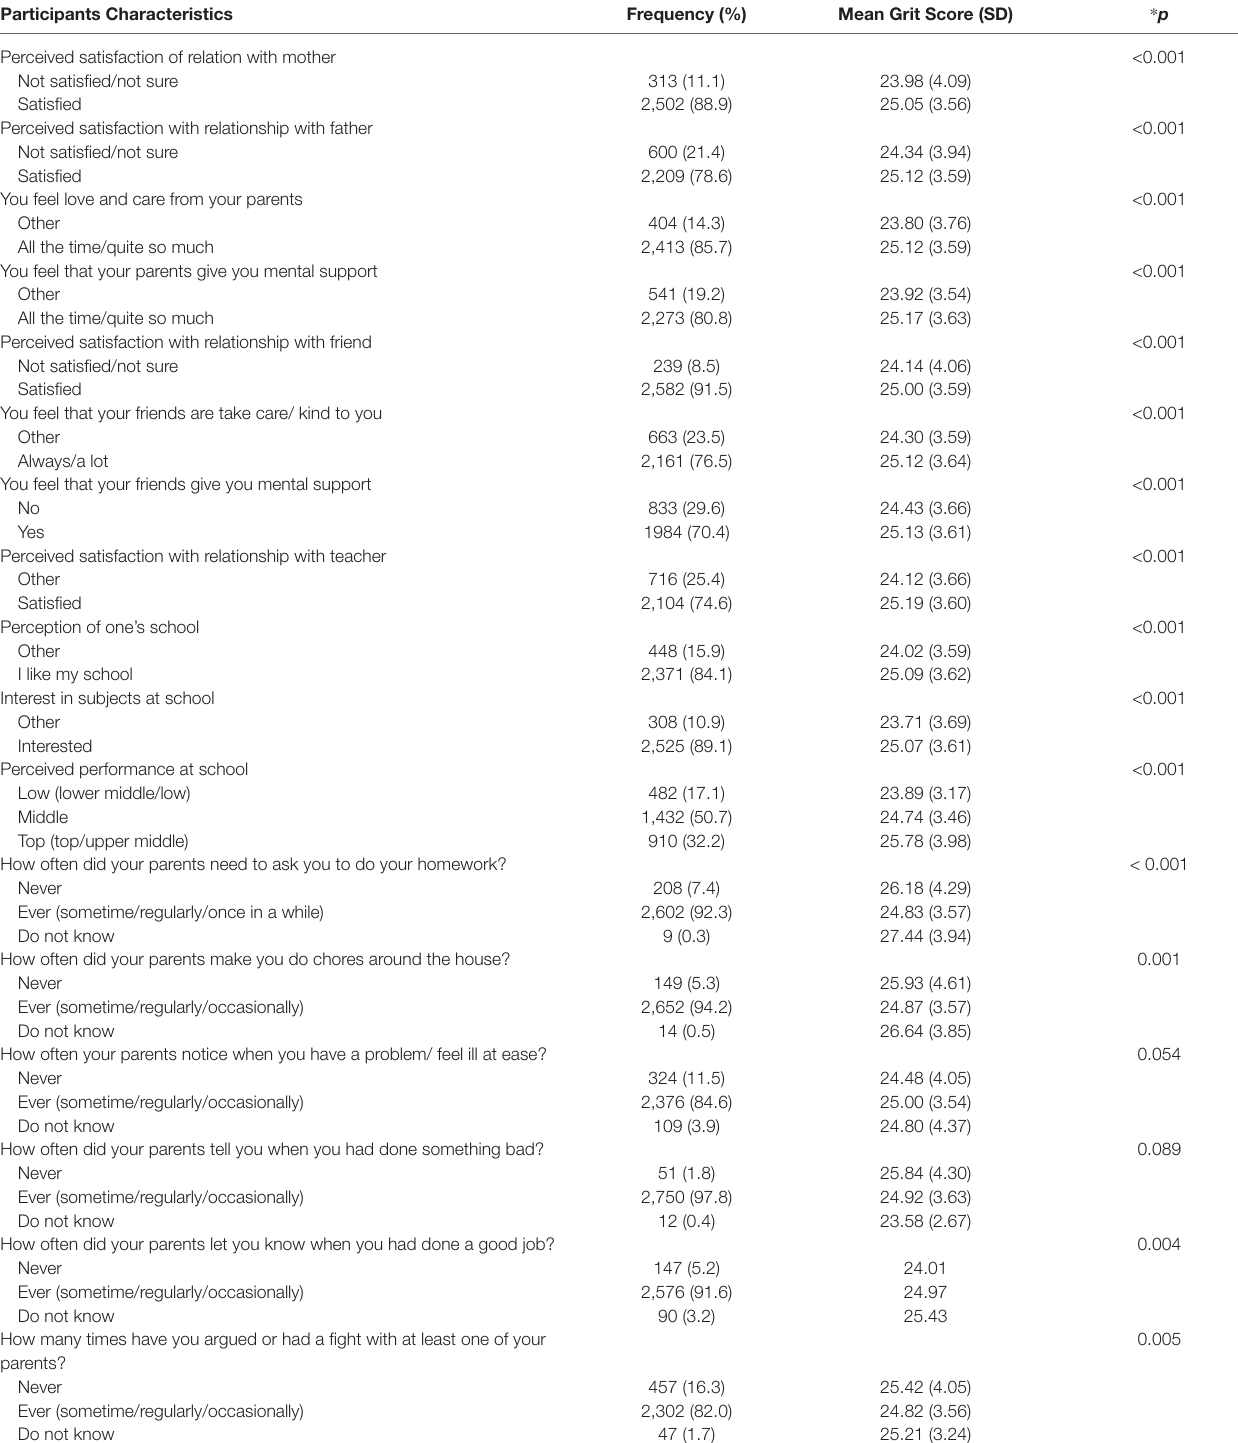
TABLE 2 | Participants’ perception and experience related to connectedness and bivariate analysis of factors associated with Grit (2,839 participants in total). Participants